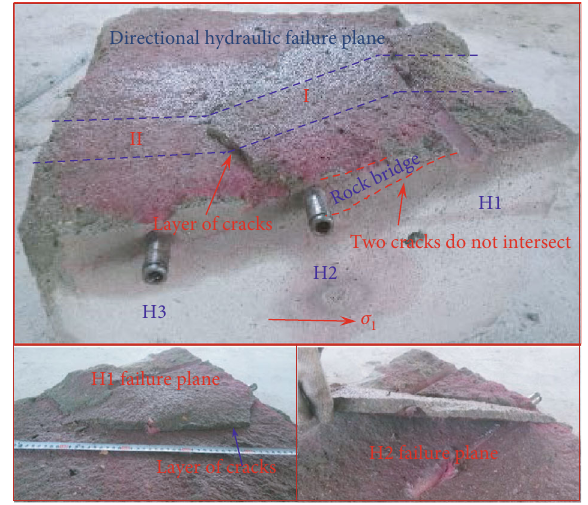
Figure 6: The integrated morphology of the failure plane [64].